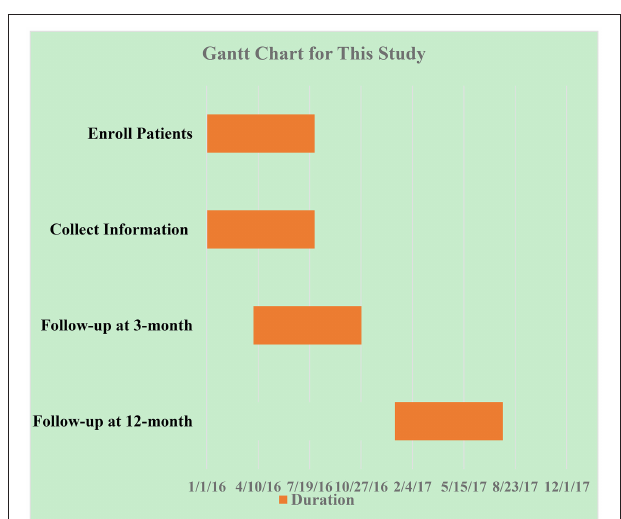
before treatment and echocardiographic parameters ( p > 0.05).